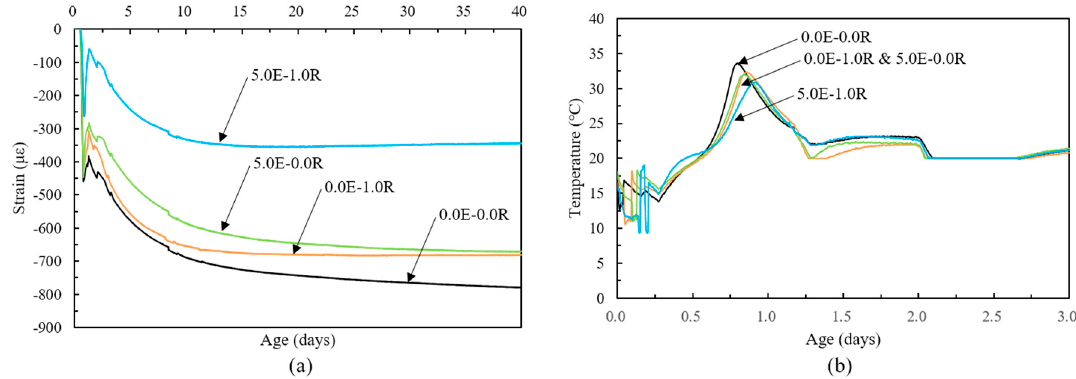
Figure 6. Autogenous shrinkage and temperature behavior; ( a ) autogenous shrinkage and ( b )